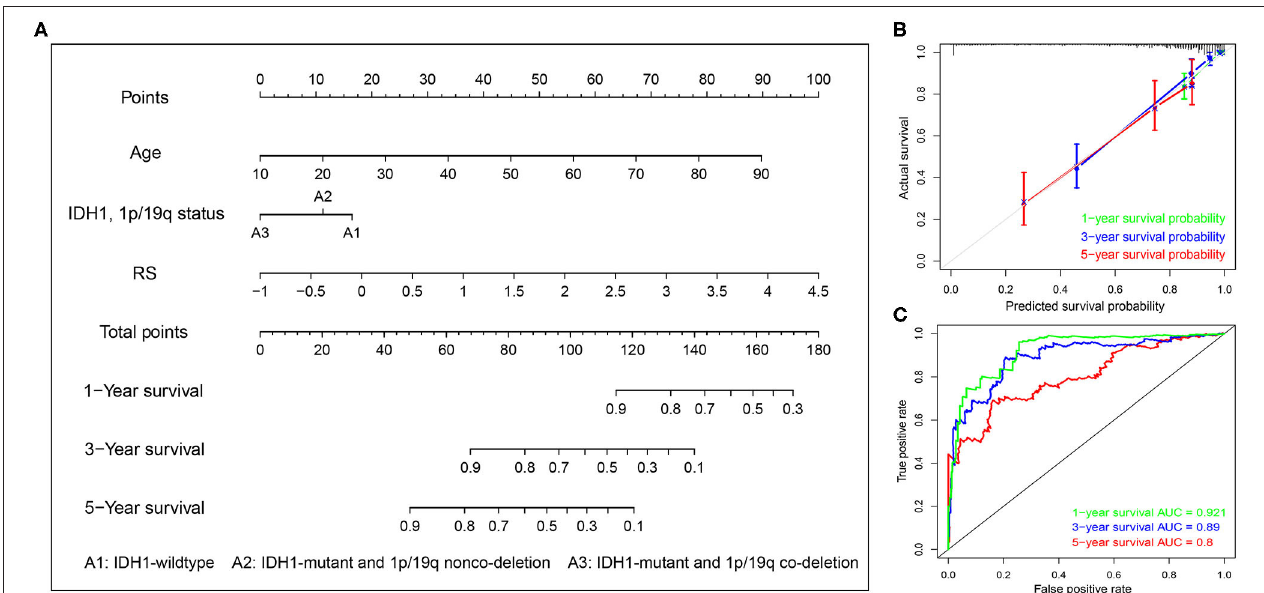
FIGURE 9 | Construction of the nomogram based on TCGA dataset. (A) A nomogram for the quantitative prediction of 1-, 2-, and 3-years survival for LGG patients based on the RS, age and IDH1 and 1p/19q status. (B) Calibration curves for the nomogram. (C) Time-dependent ROC curves for the 1-, 2-, and 3-years survival used to assess the nomogram